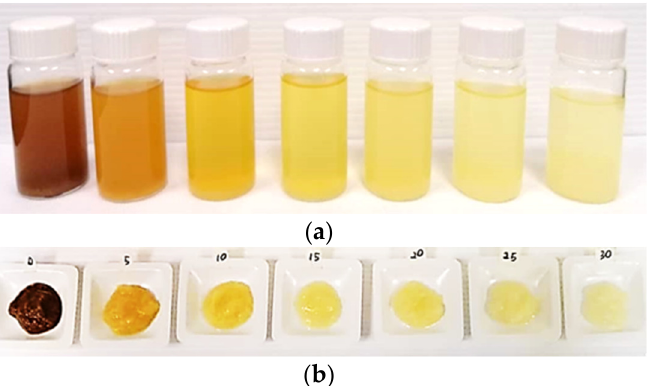
Figure 3. Washing supernatants ( a ) and insoluble residues ( b ) obtained after pre-treatment with hydrogen peroxide at concentration ranging from 0% (control) to 30%.